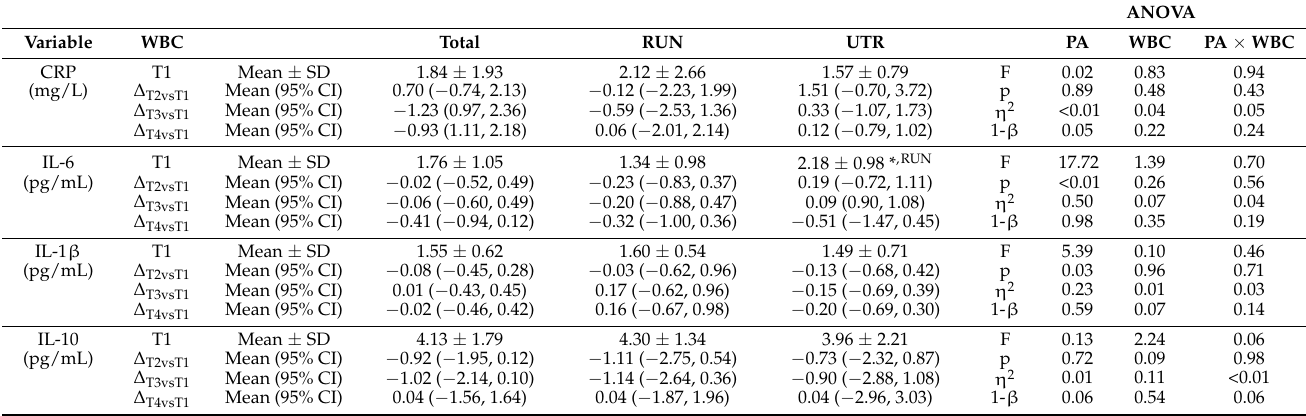
Table 3. Changes in inflammation indices concentration during the period of whole-body cryotherapy (WBC) treatment in the group of long-distance runners (RUN) and in the group of untrained men (UTR).